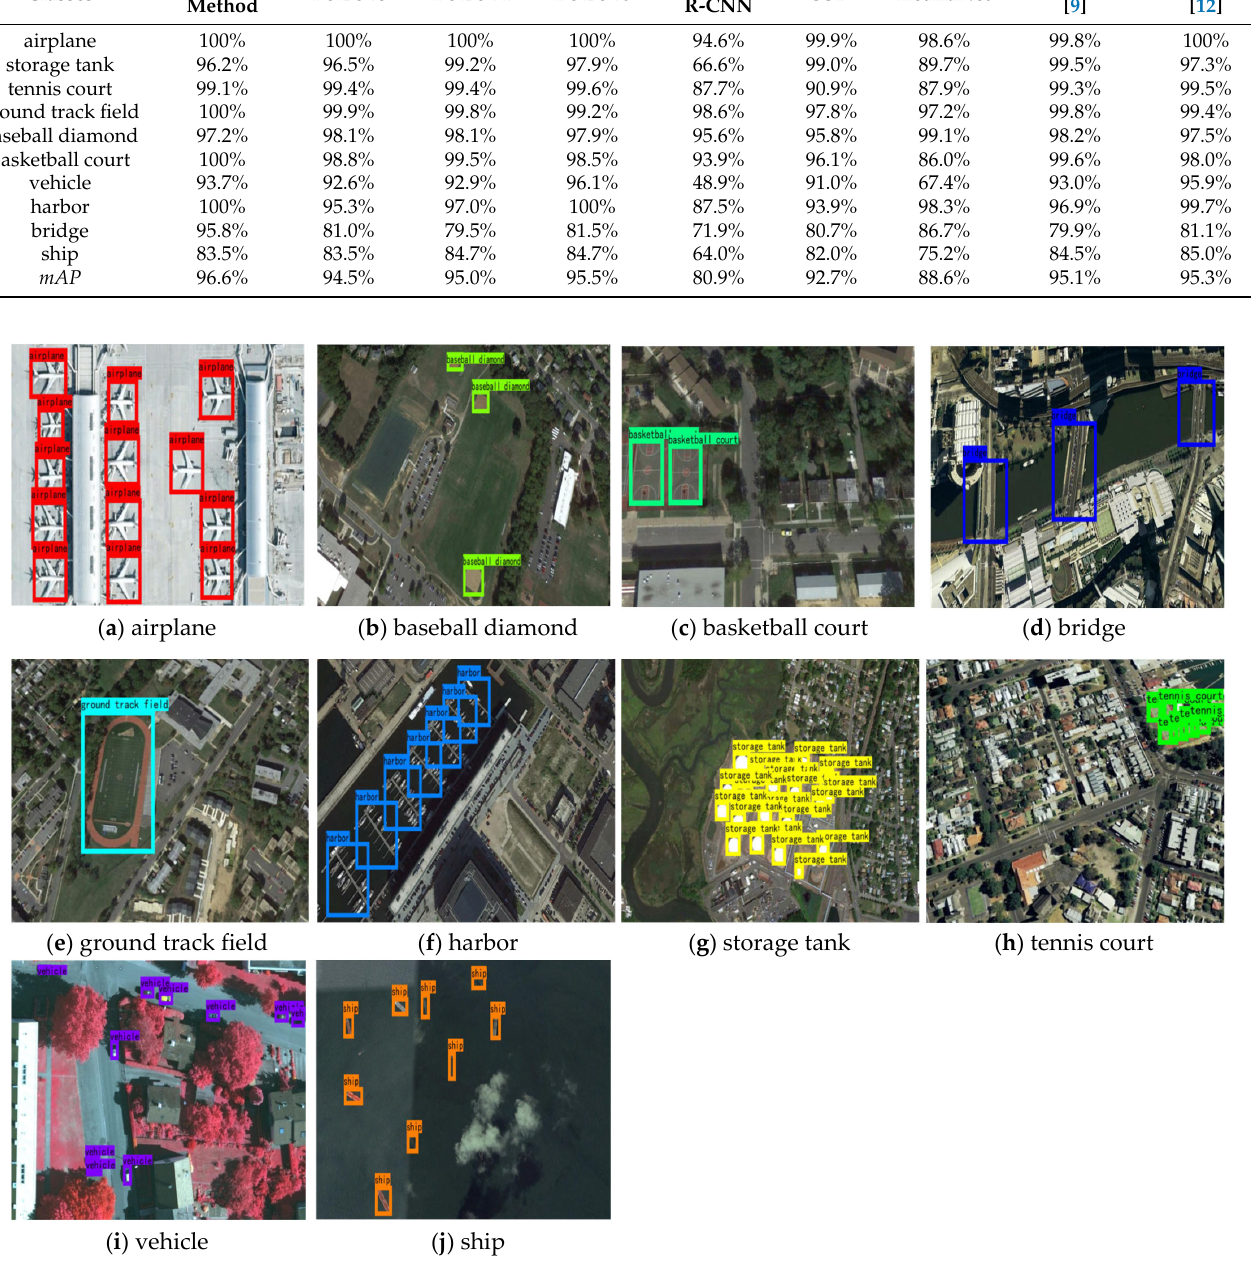
Figure 10. The detection results of our method on the NWPU VHR ‐ 10 dataset.